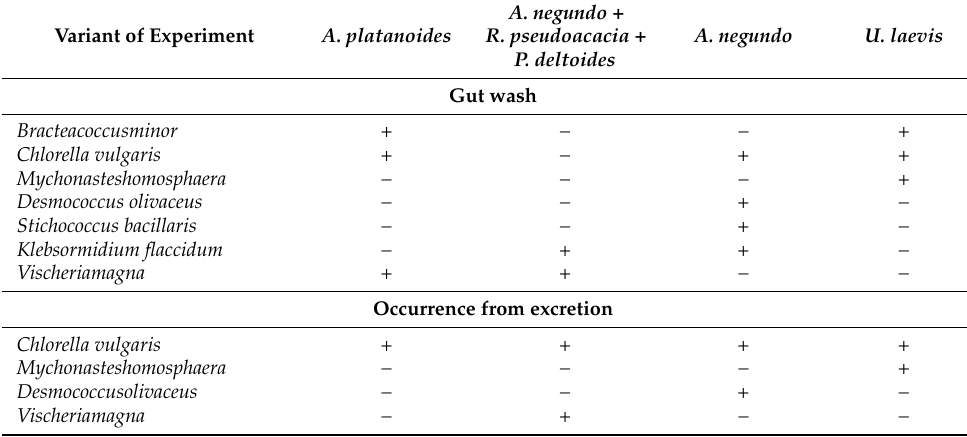
Table 3. Taxonomic composition of algae from the gut washes and excretions of R. kessleri ( n = 5) in the Y. Haharin park of Dnipro